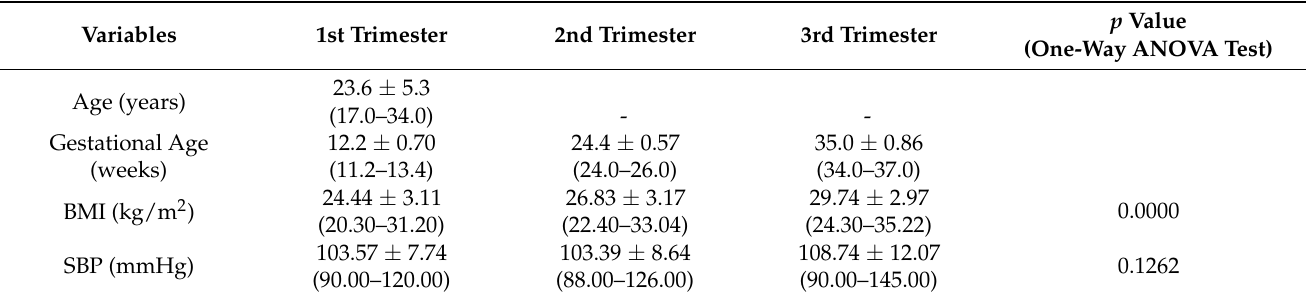
Table 2. Characteristics of preeclamptic pregnant women during the 1st trimester, 2nd trimester